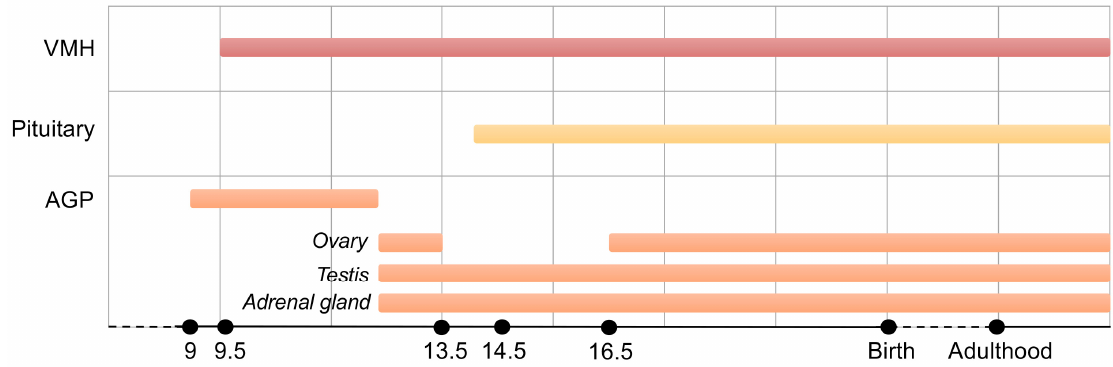
Figure 2. Timing of SF-1 expression in the mouse embryo along the hypothalamic–pituitary–adrenogonadal axis. SF-1 is expressed in those organs starting from the early stages of development, in particular in the AGP. The developmental stages before birth are indicated in days post-conception.